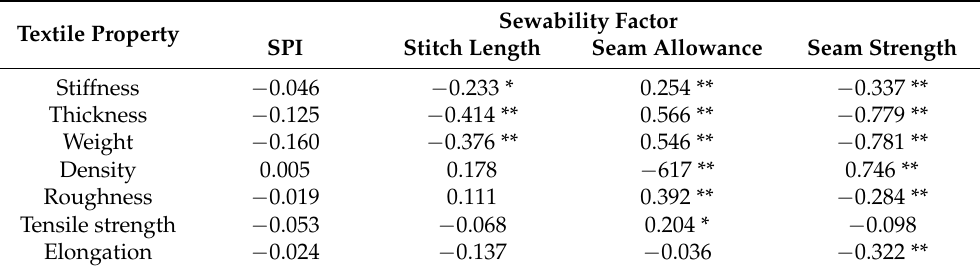
Table 7. Correlation coefficient between textile properties and sewability in the lock stitch. Sewability Factor Textile Property SPI Stitch Length Seam Allowance Seam Strength Stiffness − 0.046 − 0.233 * 0.254 ** − 0.337 ** Thickness − 0.125 − 0.414 ** 0.566 ** − 0.779 ** Weight − 0.160 − 0.376 ** 0.546 ** − 0.781 ** 0.005 0.178